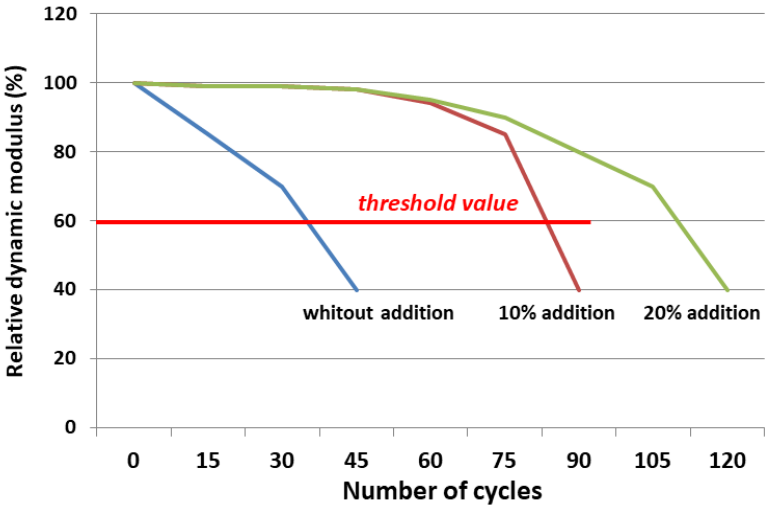
Figure 9. Variation of the relative dynamic module due to failure when reaching 60% failure.